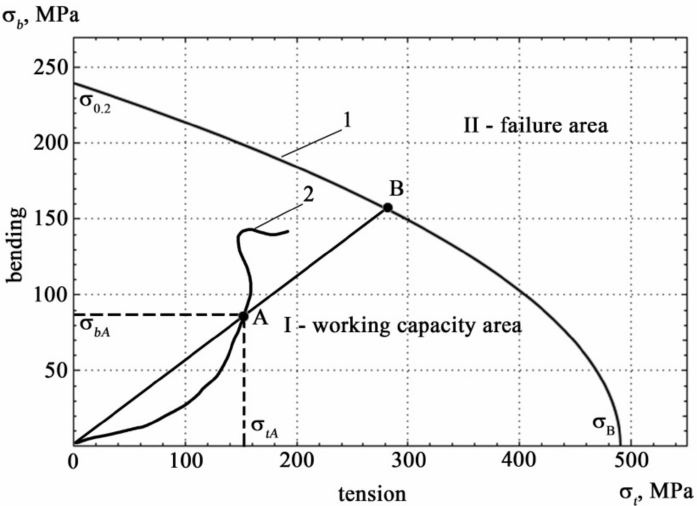
Figure 7. Boundary curve 1 and possible loading trajectory 2 in the coordinates of mechanical